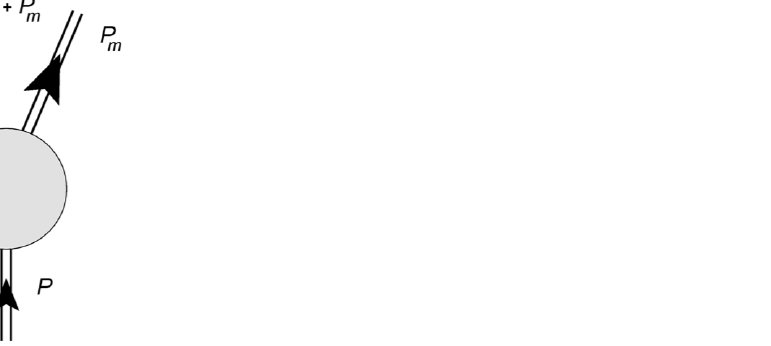
Figure 1. Feynman diagram for semi-inclusive electron scattering; figure from [1]. The 4-momenta here are discussed in the text. In particular, particle x is assumed to be detected in coincidence with the scattered electron and thus P µ x is assumed to be known. Since the total final-state momentum P (cid:48) µ is known (see text) this implies that the missing 4-momentum is also known via the relationship P µ m = P (cid:48) µ − P µ x